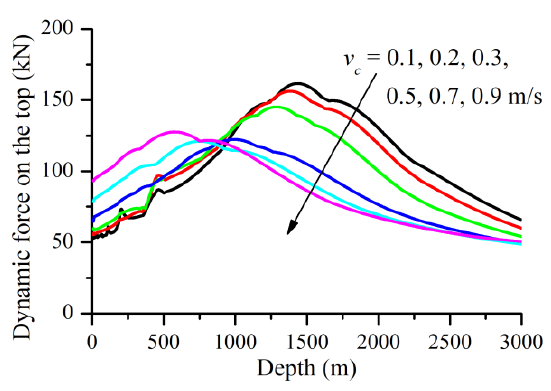
Figure 8. Influence of the lowering velocity on the dynamic force on the top of the cable.